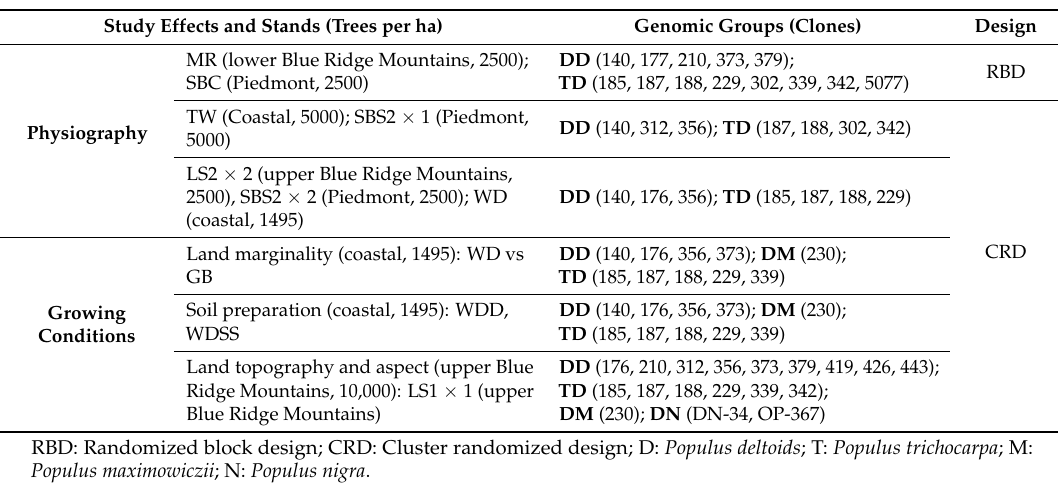
Table 2. Details of the experimental design, clones, and genomic grouping used for the study of the effects of physiography and growing conditions on poplar woody productivity, biomass allocation, and wood properties and composition. At Salisbury, three separate trials were used: SBC (randomized block design or RBD) with a 2500-tree/ha density, and SBS2 × 1 (CRD) and SBS2 × 2 (CRD) with 5000-tree/ha and 2500-tree/ha densities, respectively. Two separate LS trials were used: LS2 × 2 with a 2500-tree/ha density and LS1 × 1 with a 10,000-tree/ha density. WDD and WDSS denote disking and subsoiling treatments of soil preparation used at Williamsdale, respectively. Gibson (GB) and Williamsdale (WD) had the same clones and design